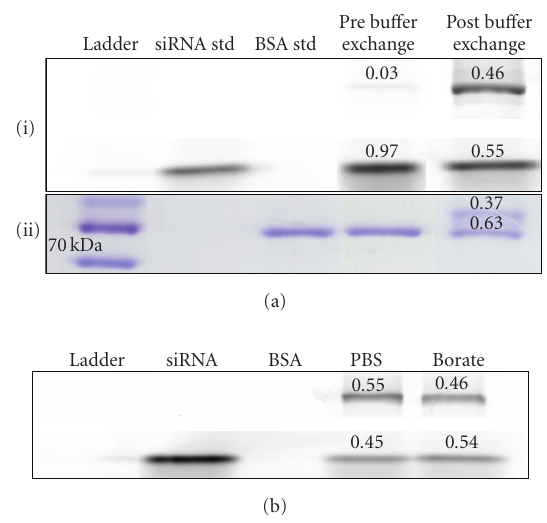
Figure 3: Ultrafiltration dramatically increases siRNA-albumin conjugate yield. (a) SDS-polyacrylamide gel showing outcome of siRNA-BSA conjugation reaction without prior ultrafiltration (lane 4) and subsequent to ultrafiltration of siRNA (lane 5). A 15-fold increase in conjugate band intensity wasobserved using ultrafiltered siRNA, compared to amine-modified siRNA simply reconstituted in bu ff er, when scanned at 488 nm. A visible band at the predicted conjugate size was also apparent after staining with Coomassie Brilliant Blue. (b) siRNA conjugation was e ffi cient after bu ff er exchange with either PBS (pH 7.4) or borate bu ff er (pH 8). siRNA std :siRNA standard; BSA std :BSA standard.